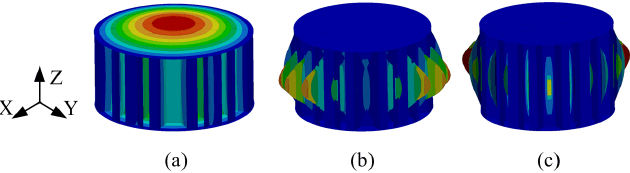
Figure 13. Simulated mode shapes for the B 3 -type panel: ( a ) mode at 4917 Hz; ( b ) mode at 6597 Hz; and ( c ) mode at 6634 Hz.